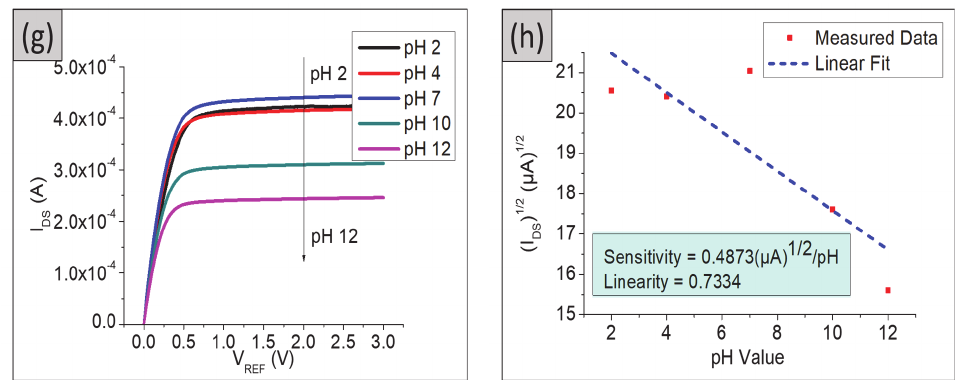
Figure 5. Output characteristics (I DS –V DS ) and sensitivity in saturation region for ( a , b ) TiO 2 thin film, ( c , d ) TiO 2 –PANI bilayer composite, ( e , f ) TiO 2 –PANI composite thin films, and ( g , h ) ITO substrate.